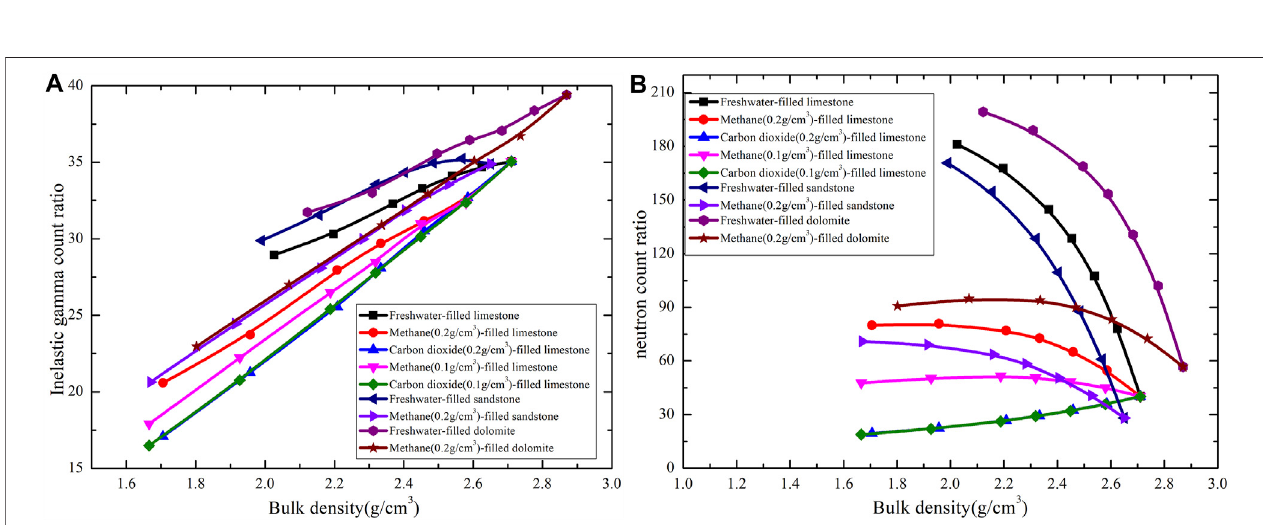
FIGURE 5 | Cross-plot of inelastic scattering gamma ray count and bulk density for various mineral and fl uid combinations: (A) near detector; (B) far detector.